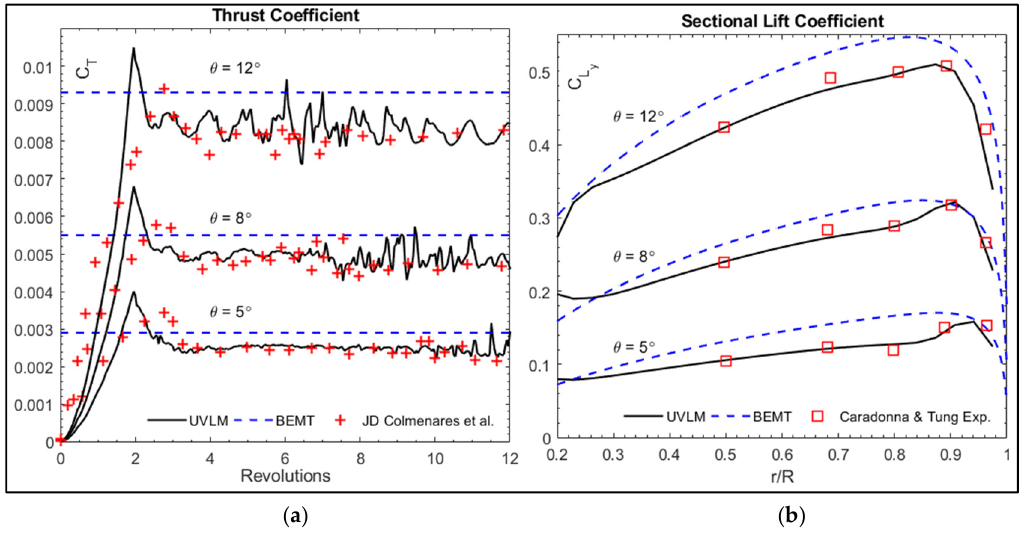
Figure 8. Prediction by UVLM and BEMT compared to the literature: ( a ) C T ; ( b ) C Ly.